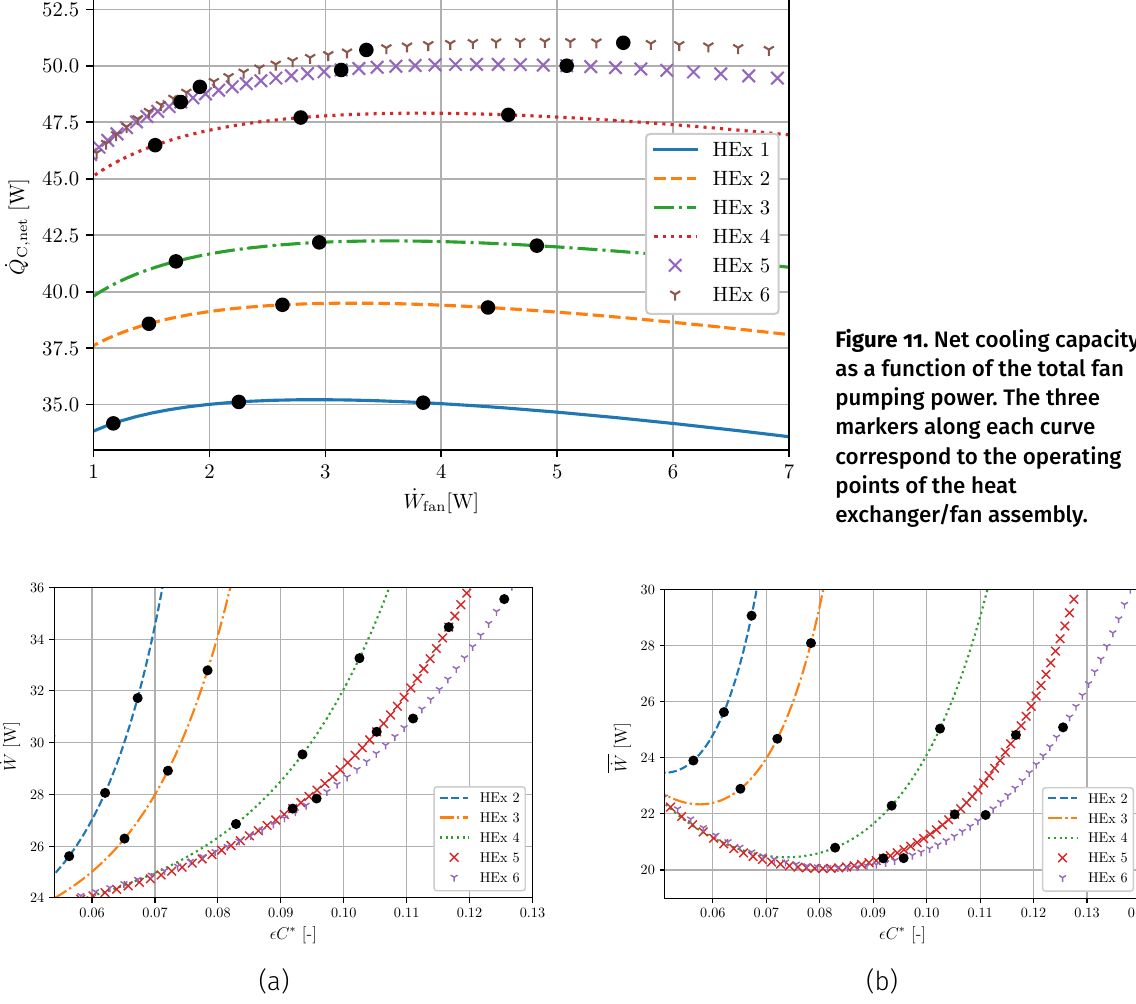
Figure 12. Power consumption of the system. (a) Instantaneous; (b) Average. The three markers along each curve correspond to the operating points of the heat exchanger/fan